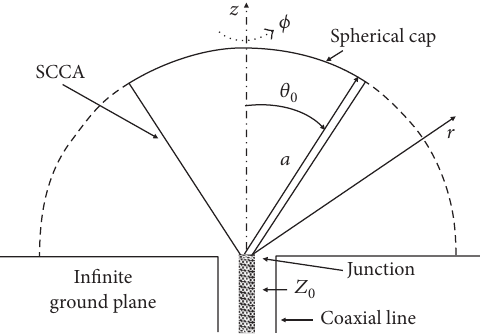
Figure 1: Vertical plane cut of an SCCA fed by a coaxial feed line. The antenna is a body of revolution over the 𝑧